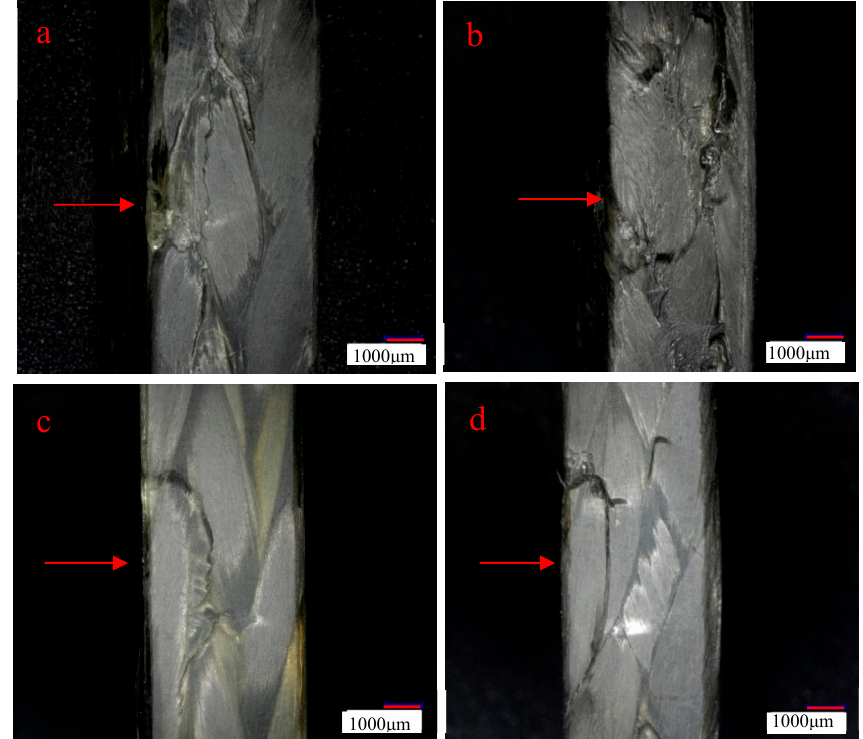
Figure 7. Lateral morphology of bending fracture of 3Dim–5Dir braided composites at 90 °C with different durations ( a ) at room temperature; ( b ) 90 °C 0.25 h; ( c ) 90 °C 10 h; ( d ) 90 °C 30 h.